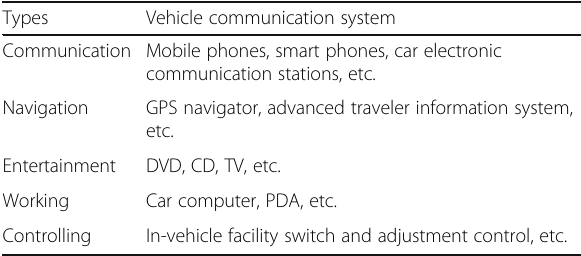
Table 3 In-vehicle communication system